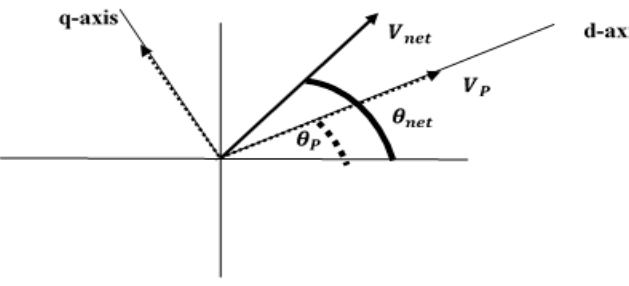
7 of 20 Figure 5. Simplified equivalent circuit of studied micro-grid and grid-side converter. (cid:1873)(cid:3556) (cid:3040)(cid:3034)(cid:3045)(cid:3036)(cid:3031) = (cid:2835)̃ (cid:3039)(cid:2870) ((cid:2016) (cid:3017) ) · (cid:1852) (cid:3013) (cid:1852) (cid:3041)(cid:3032)(cid:3047) (cid:1852) (cid:3013) + (cid:1852) (cid:3041)(cid:3032)(cid:3047) = (cid:3495)(|(cid:2835)̃ (cid:3039)(cid:2870)(cid:3031) | (cid:2870) + (cid:3627)(cid:2835)̃ (cid:3039)(cid:2870)(cid:3044) (cid:3627) (cid:2870) )(cid:3628) (cid:1852) (cid:3013) (cid:1852) (cid:3041)(cid:3032)(cid:3047) (cid:1852) (cid:3013) + (cid:1852) (cid:3041)(cid:3032)(cid:3047) (cid:3628)(cid:1857) (cid:3037)((cid:3087) (cid:3265) (cid:2878)(cid:3101) (cid:3265) )